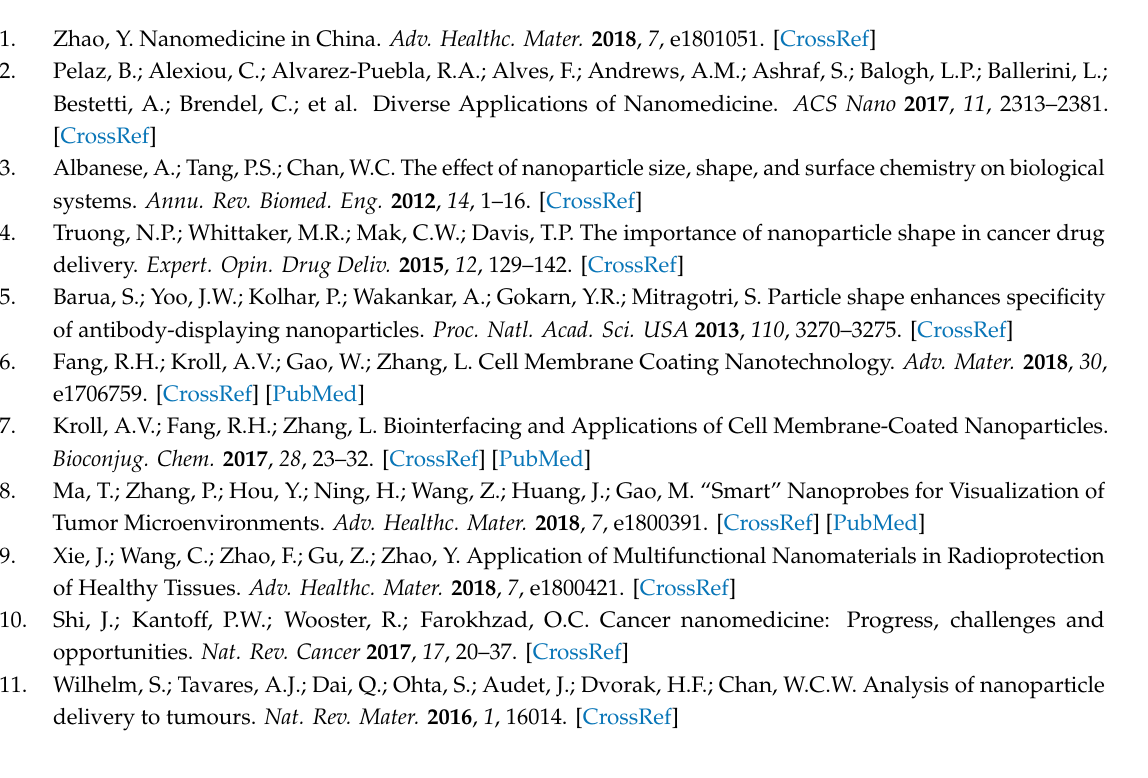
Supplemental File 1: Supplementary figures and tables. Supplemental File 2: Identified proteins list from LC / MS. Supplemental File 3: EnrichGO result